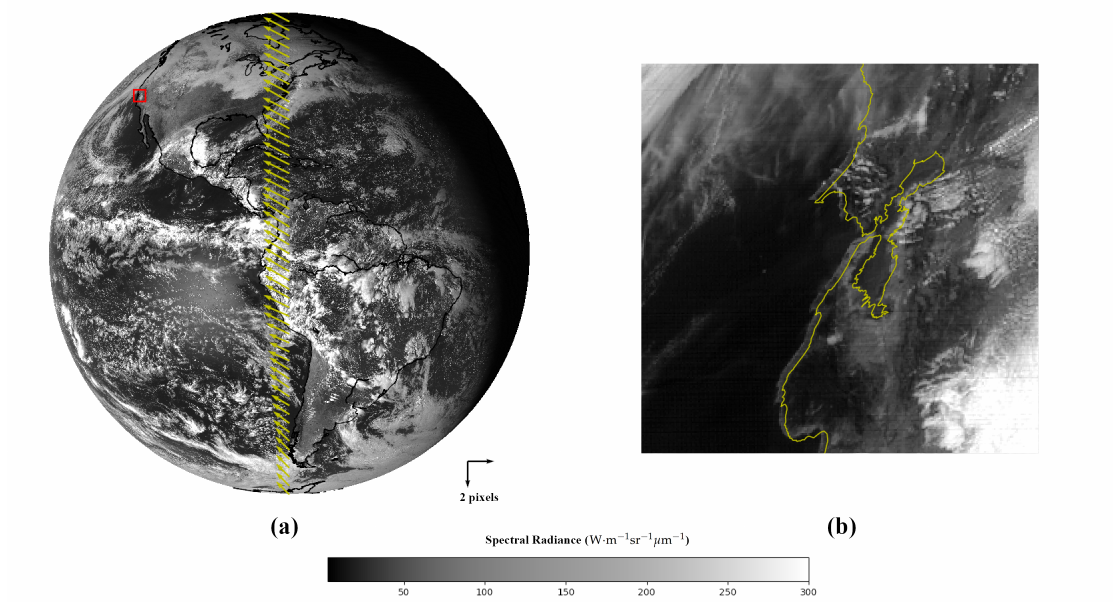
Figure 5. Geolocation errors of GOES16 ABI L1b data on 23 January 2018, 19:45 UTC. Panel ( a ) shows the TOA spectral radiance of Band 2 (0.64 µ m) in the background, with the foreground yellow arrows indicating the geolocation error vectors ( ∆ l , ∆ c ) at different lines of the full disk image. The scales of the arrows are shown in the right-lower corner. Panel ( b ) shows an enlarged image of the zoomed-in area (i.e., San Francisco Bay) marked by the red rectangle in Panel ( a